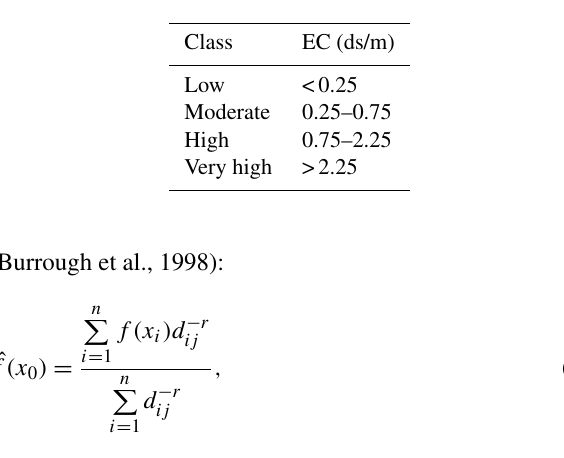
Figure 2. Location of the study area (DEM with spatial resolution of 30m) (source: http://earthexplorer.usgs.gov). Table 1. Classification of water EC values (Kumar et al., 2003).